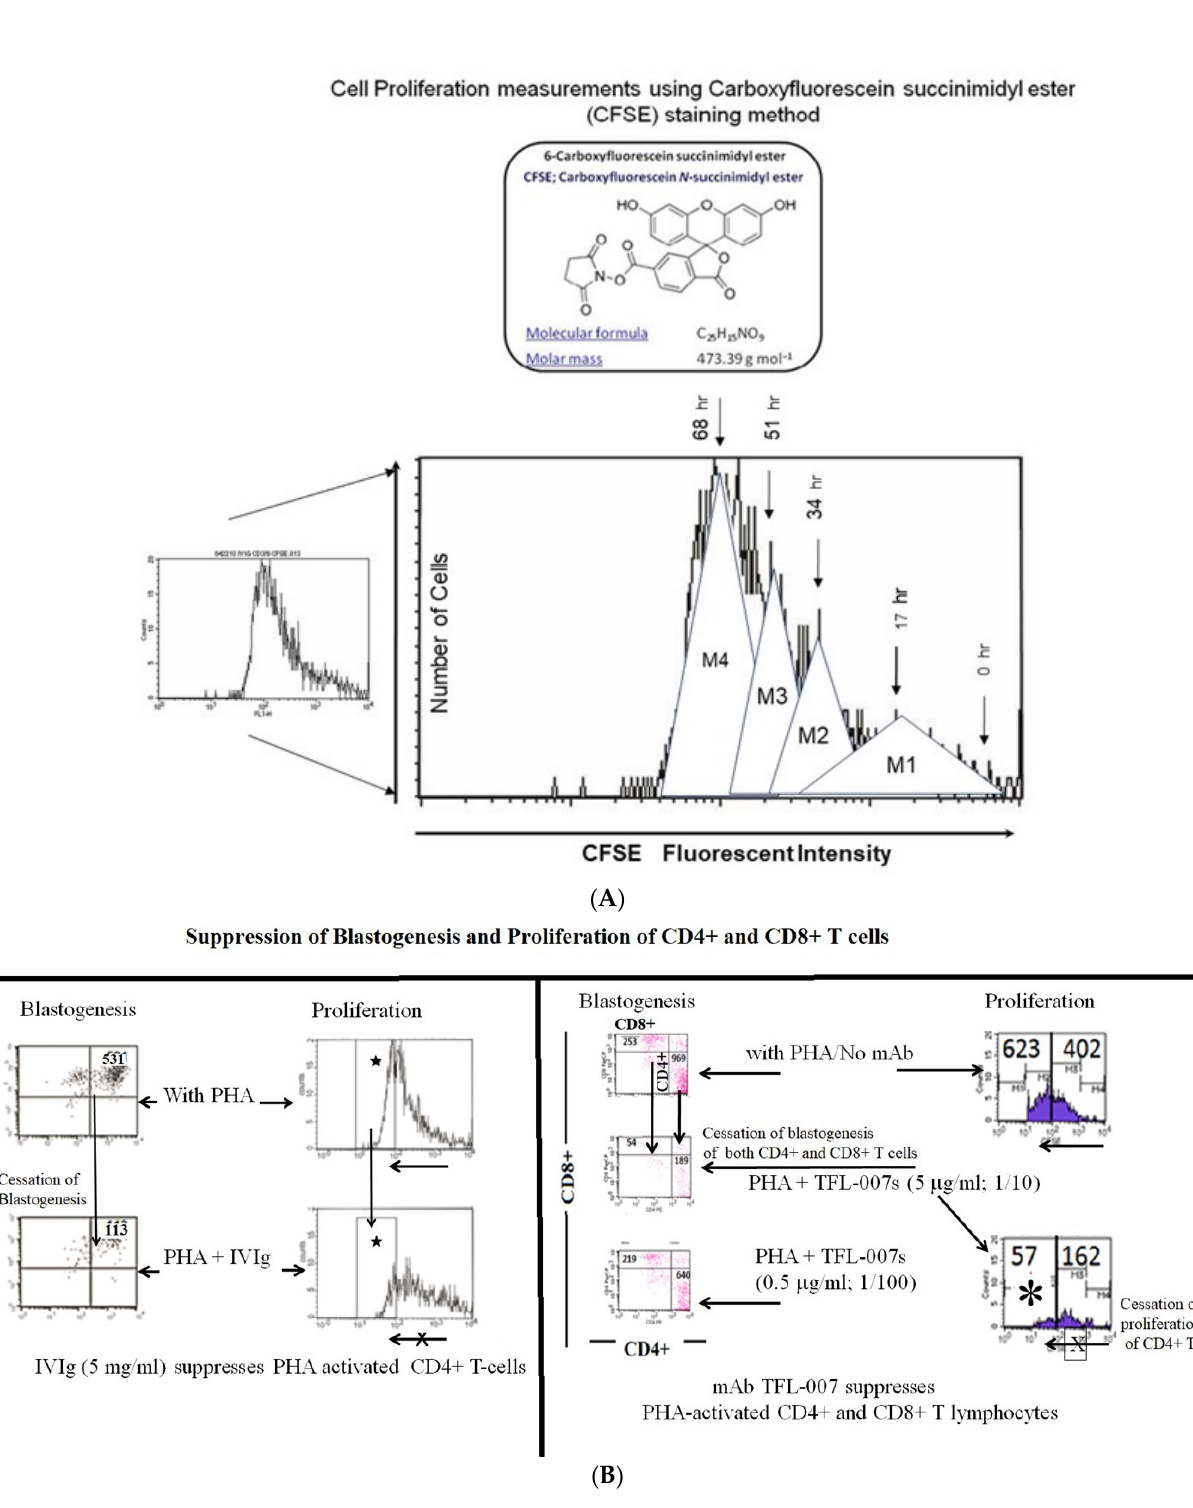
Figure 6. ( A ). The proliferation assay is based on labeling the purified T-cells during PHA activation with the intracellular fluorescent dye carboxyfluorescein succinimidyl ester (CFSE: C25H15NO9; mol. mass: 473.39 g/mol) and using flow cytometry, measuring mitotic activity by the successive twofold reductions in fluorescent intensity of the T-cells placed in culture for 72 h. CFSE is cell-permeable and is retained for long periods within cells by covalently coupling by means of its succinimidyl group to intracellular molecules. Due to this stable linkage, once incorporated within cells, CFSE is not transferred to adjacent T-cells but remains in the cell even after several mitotic divisions. ( B ). Suppression of blastogenesis and proliferation of CD4+ T-cells by IVIg (Globex) and HLA-I polyreactive mAb TFL-007 at similar protein concentrations. The CFSC profile illustrates suppression as indicated by asterisks.